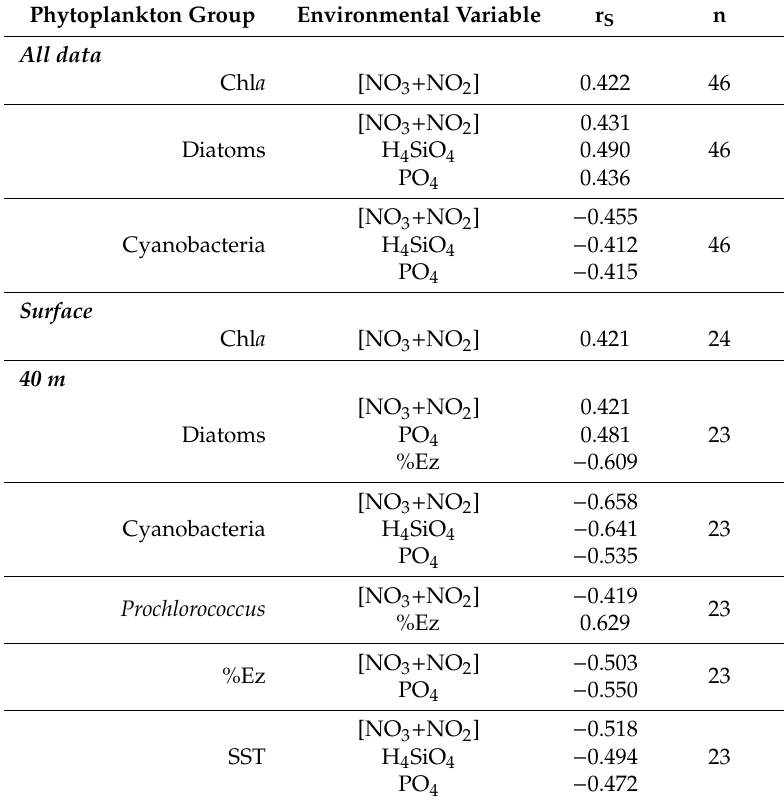
Table 6. Results of the statistical analyses performed to evaluate the relationship between environmental variables and the contribution of phytoplankton groups to Chl a , using the Spearman correlation coe ffi cient (r S ). Only the statistically significant r S are shown ( α = 0.05), considering that r critical (n = 46) = 0.246, r = 24) = 0.353 and r = 23) = critical (n critical (n